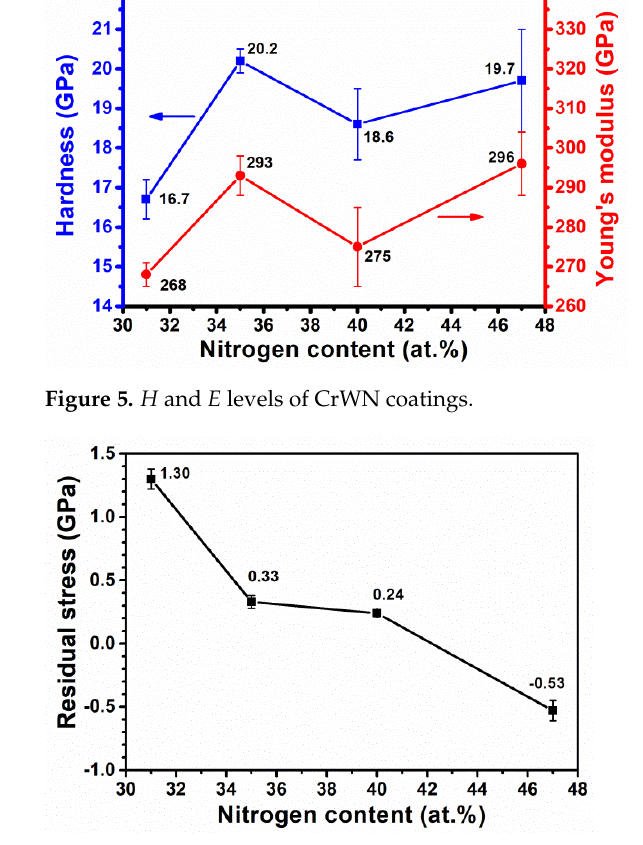
Figure 6. Residual stresses of CrWN coatings.